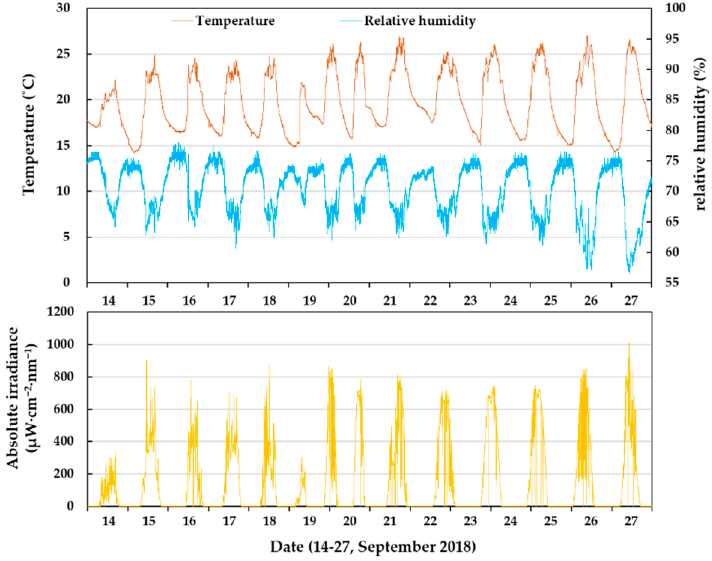
Figure 1. The temperature, relative humidity and solar radiation in the glasshouse during the experiment duration (14–27 September